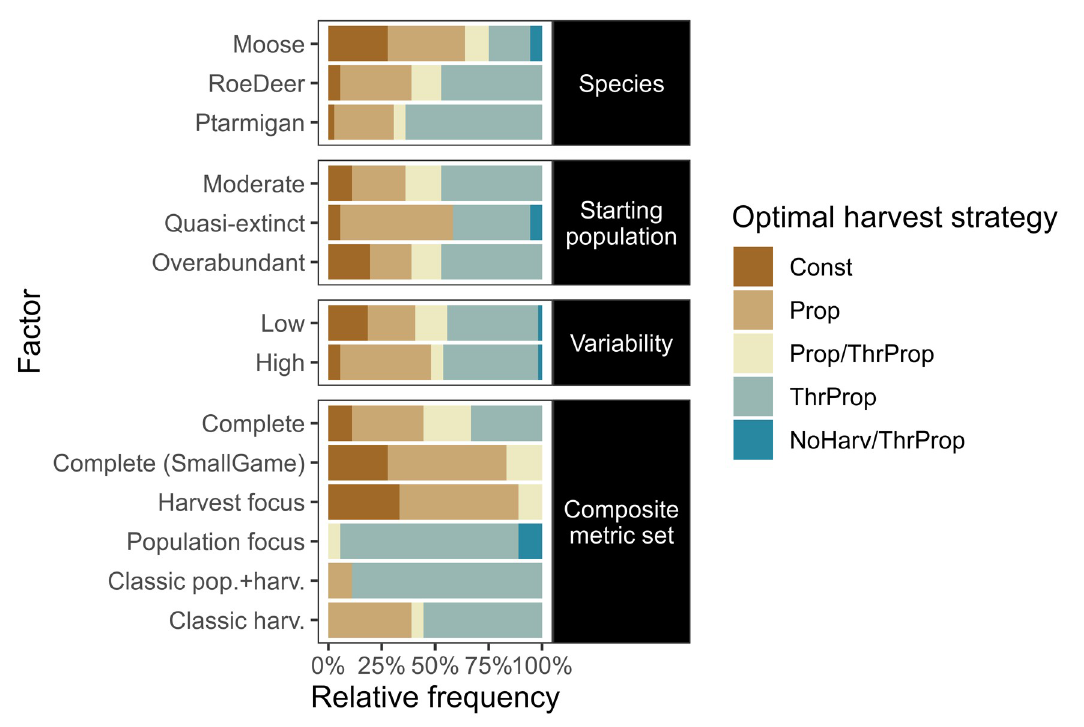
Fig 7. Optimal strategy across environmental and evaluation contexts. Relative frequency of optimal harvest strategy (or jointly optimal strategies) by environmental and evaluation context factors (y-axis). Each bar summarises the simulations including the factor specified on the y-axis. Optimal strategies are determined by ranking their respective best performing harvest parameter levels across harvest strategies. Pairwise comparisons between contexts are given in S2.4 Section in S2 Appendix.